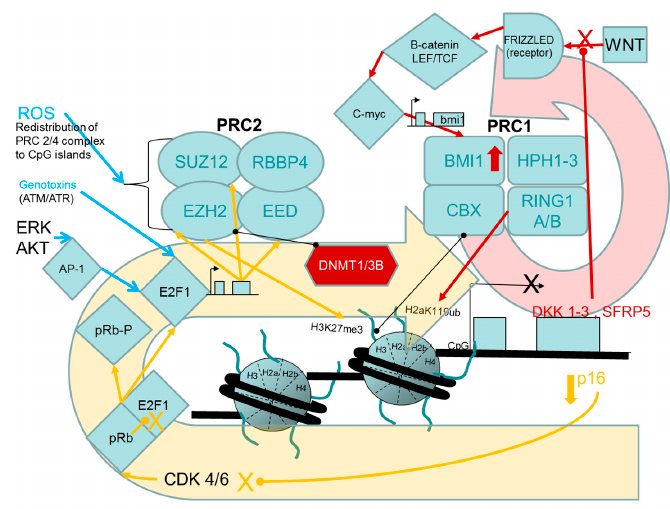
Figure 5. Examples of two pathways of histone modification by polycomb complexes leading to suppression of selected TSG . Two potentially reinforcing pathways (one pathway leading from experimentally up-regulated BMI1 expression, in red connecting arrows, and the other pathway leading from experimental down-regulation of p16 the gene, in orange connecting arrows, respectively.) that could lead to stable TSG repression are